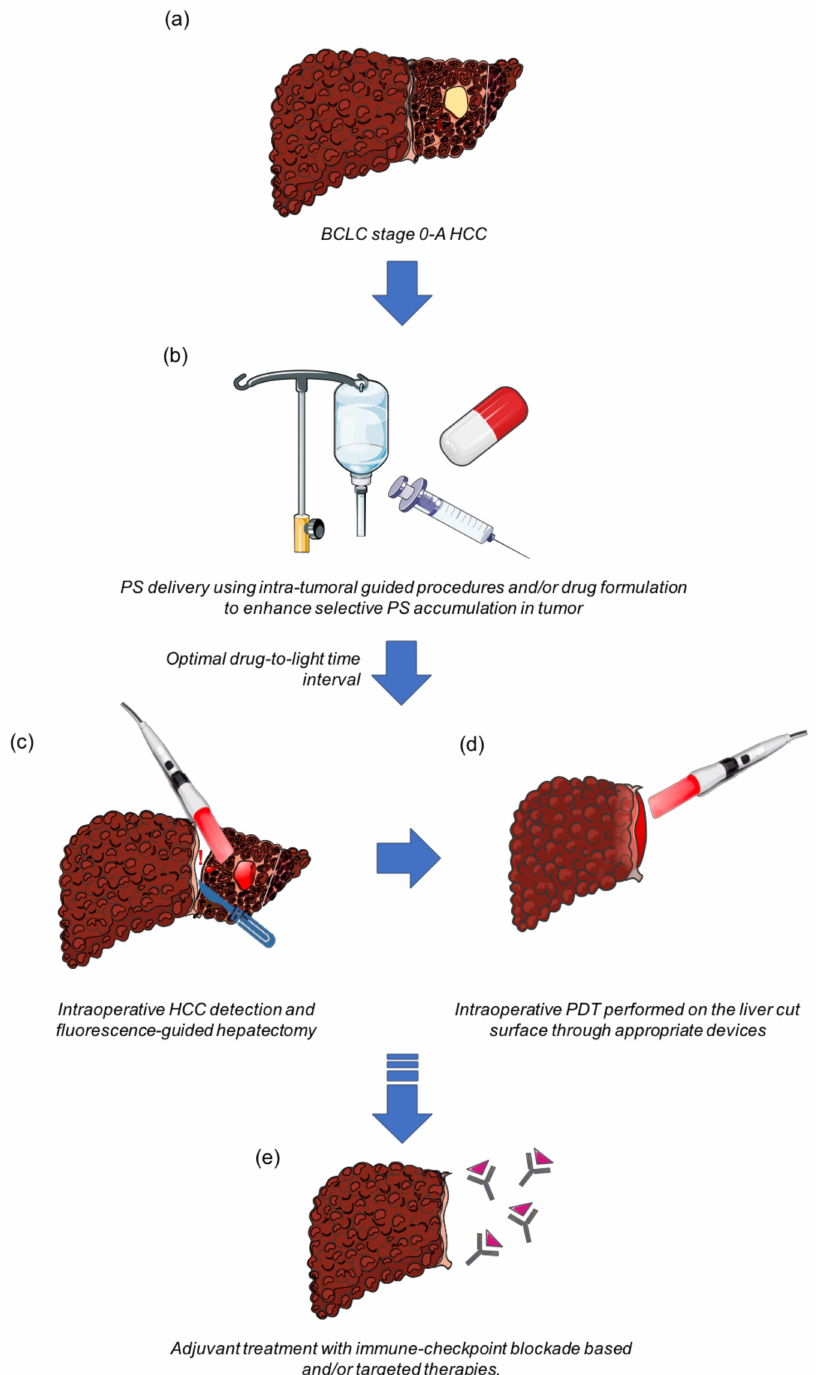
Figure 1. Proposed strategy for using intraoperative PDT as an adjuvant treatment in liver resection for HCC. ( a ) Patient’s eligibility criteria for liver resection should be those recommended by the AASLD-EASL international guidelines; ( b ) prior to the hepatectomy, a PS (or its biological pre- cursor) shall be administered using either loco-regional or systemic route to enhance the tumoral accumulation of the PS; ( c ) after an optimal drug-to-light interval, the PS generated fluorescence shall